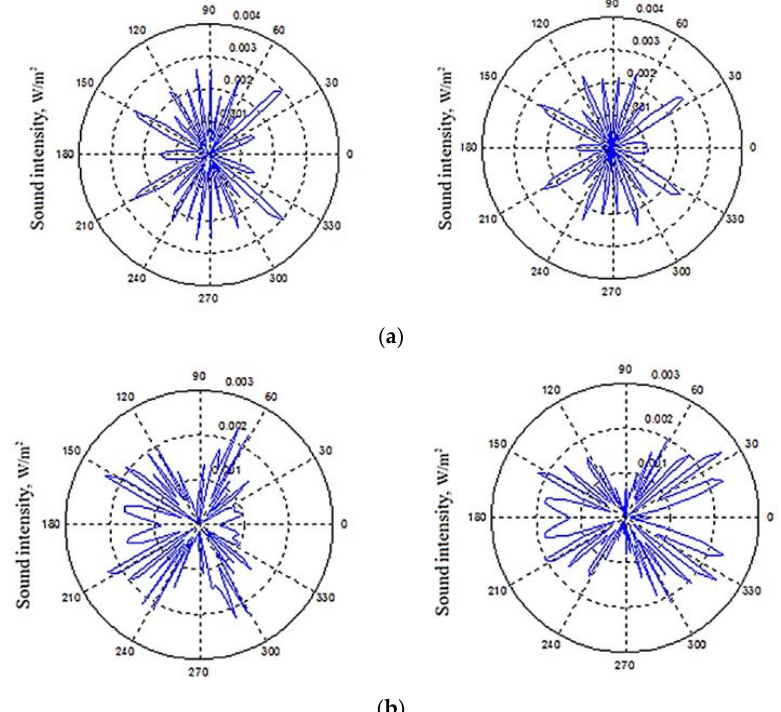
Figure 19. The intensity polar pattern diagram of uncloaked (left side) and cloaked objects (right side) with incident wave frequency f = 800 Hz; ( a ) the intensity polar pattern of the total sound field; ( b ) the intensity polar pattern diagram of the normalized sound field (scattered field of the object). In Figure 19a, the curve of the uncloaked object shows a peak scattering energy in forward directions of 150 and 210 polar degrees and backward directions of 45 and 315 polar degrees.